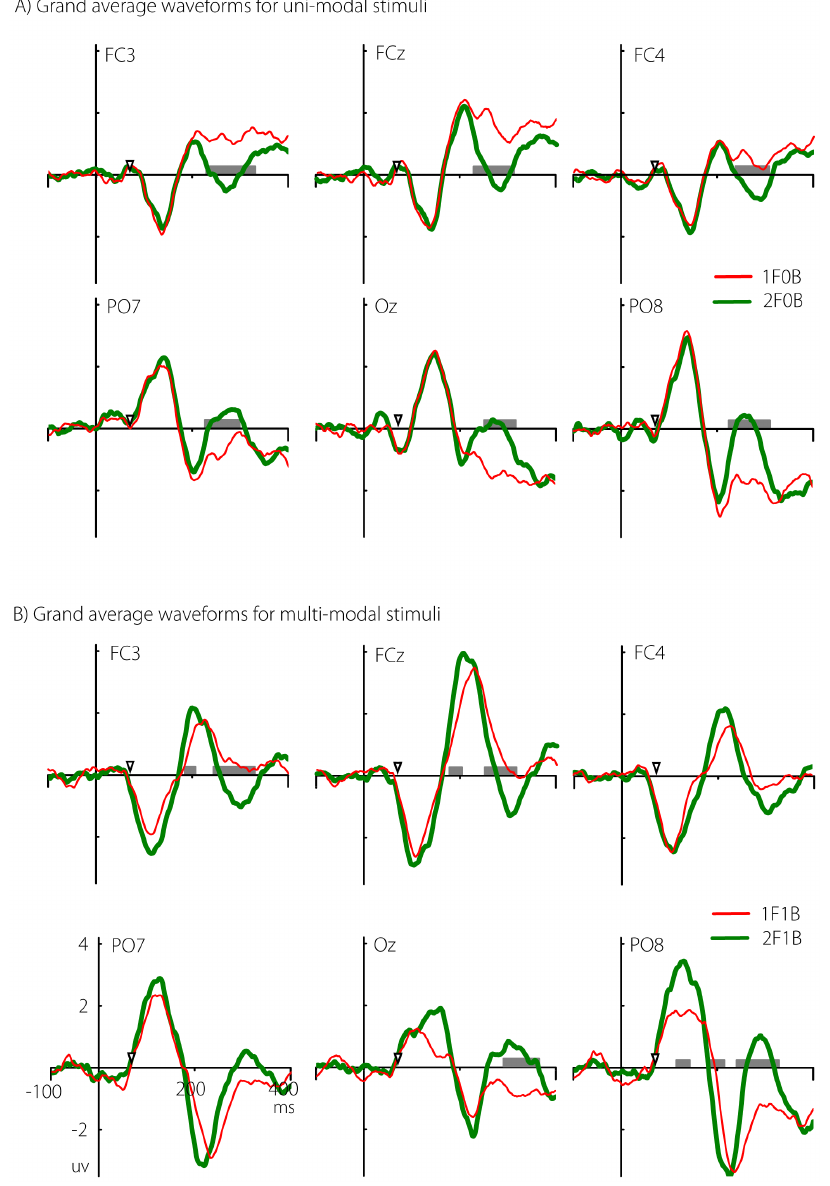
Figure 3. Grand average ERPs for UNI (top panel) and MULTI (bottom panel) stimuli. Significant differences between the waveforms are marked with grey boxes (permutation test, p , .05). The x-axis represents time relative to the first flash. The time of the second flash (67 ms) is marked on the x-axis.